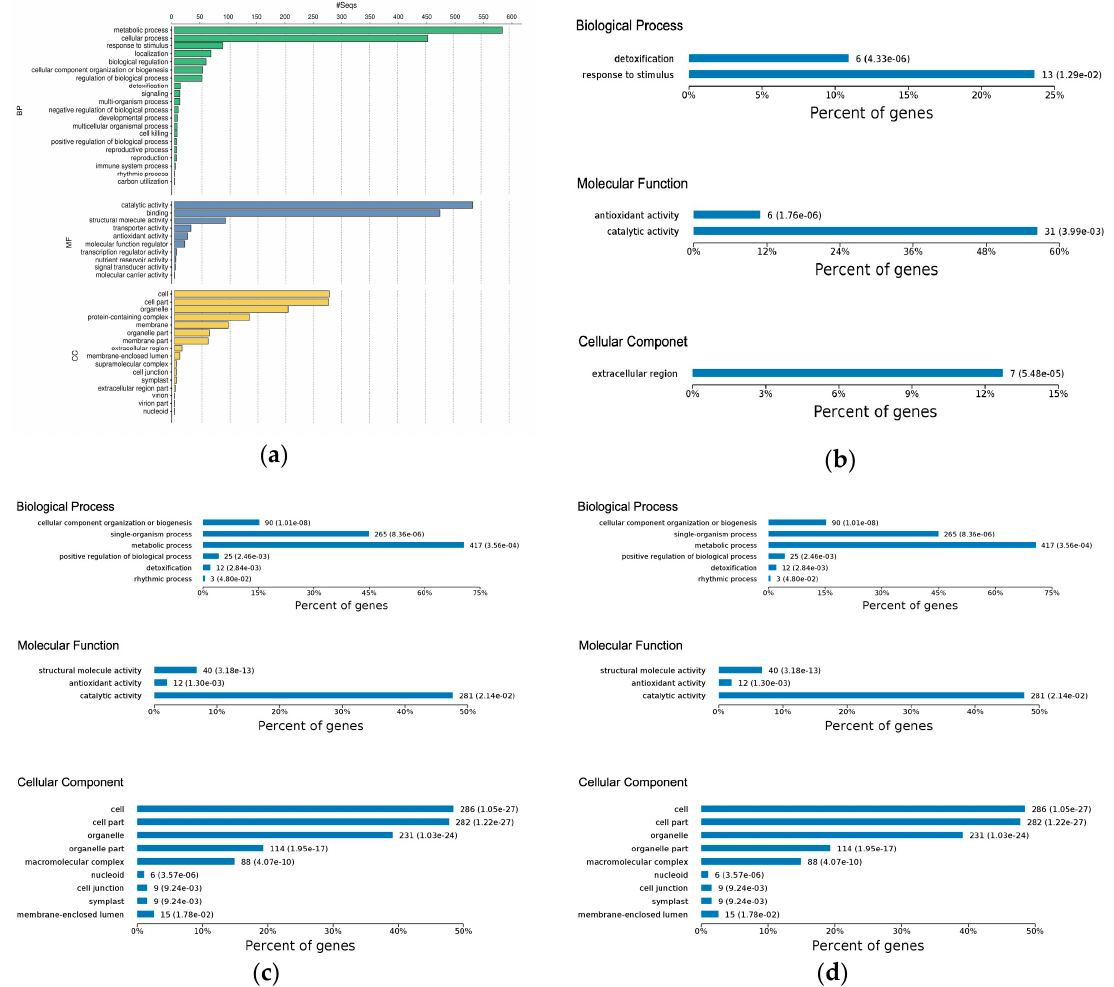
Figure 3. ( a ) Gene Ontology functional classification of all DEPs; bar chart shows the distribution of differentially-expressed proteins among the GO biological process (BP), molecular function (MF), and cellular component (CC). ( b ) GO-based functional enrichment analysis of DEPs at early disease stage. ( c ) GO-based functional enrichment analysis of DEPs at late disease stage. ( d ) Kyoto Encyclopedia of Genes and Genomes pathway enrichment of DEPs at the early and late disease stages.